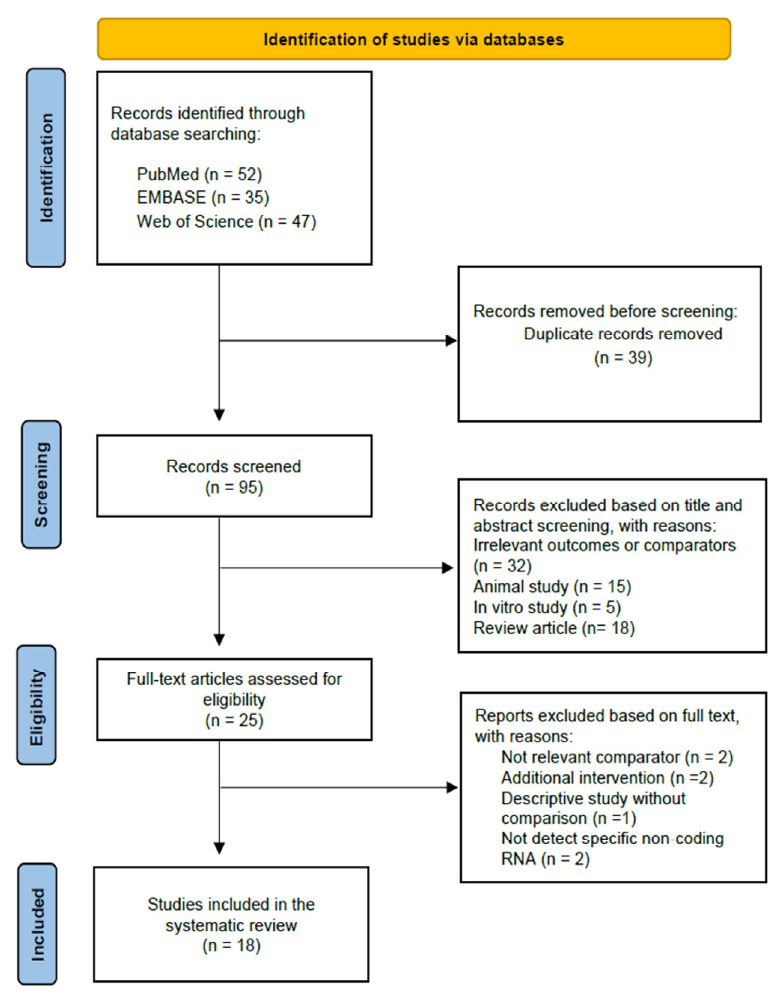
Figure 1. Flowchart of the literature search and selection process.